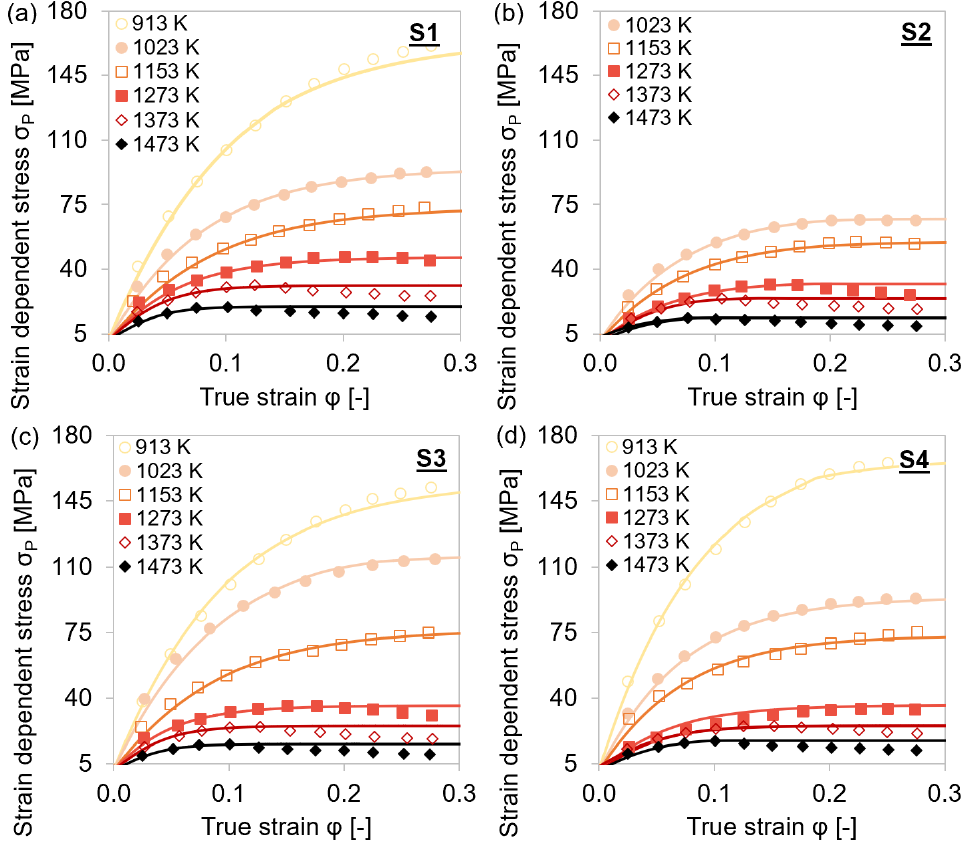
Figure 13. Comparison of experimental σ P (symbols) and simulated (lines) flow curves during single-hit compression tests with 25 s holding time before deformation, 0.01 s − 1 strain rate at 913–1473 K. ( a – d ) MA steels S1–S4.